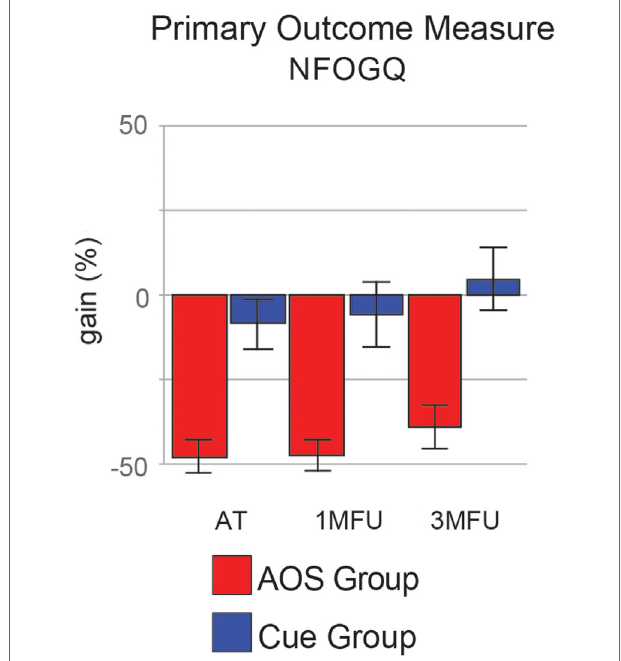
FiGUrE 2 | Improvement (gain) of the two groups in the primary outcome measure [New Freezing of Gait Questionnaire (NFOGQ)], at the three evaluation times. Error bars are 1